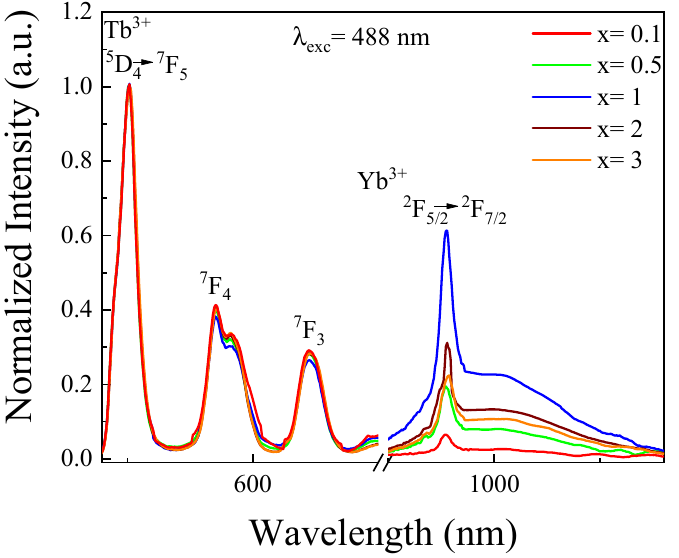
Figure 2. Emission spectra of 2.5Tb 3+ -xYb 3+ co-doped phosphate glasses normalized to 5 D 4 → 7 F 5 peak.